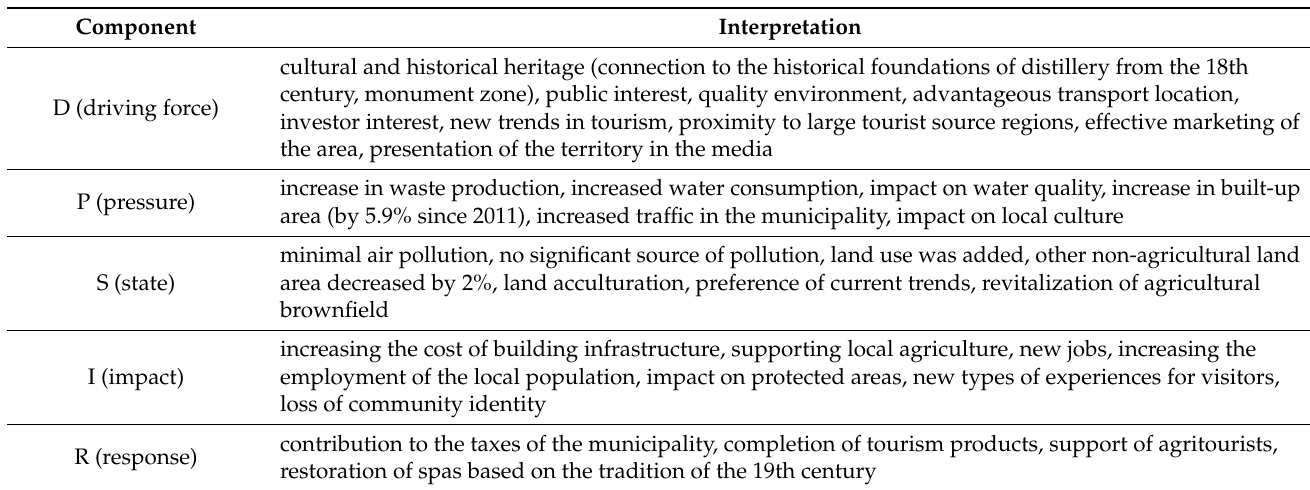
Table 3. DPSIR model for